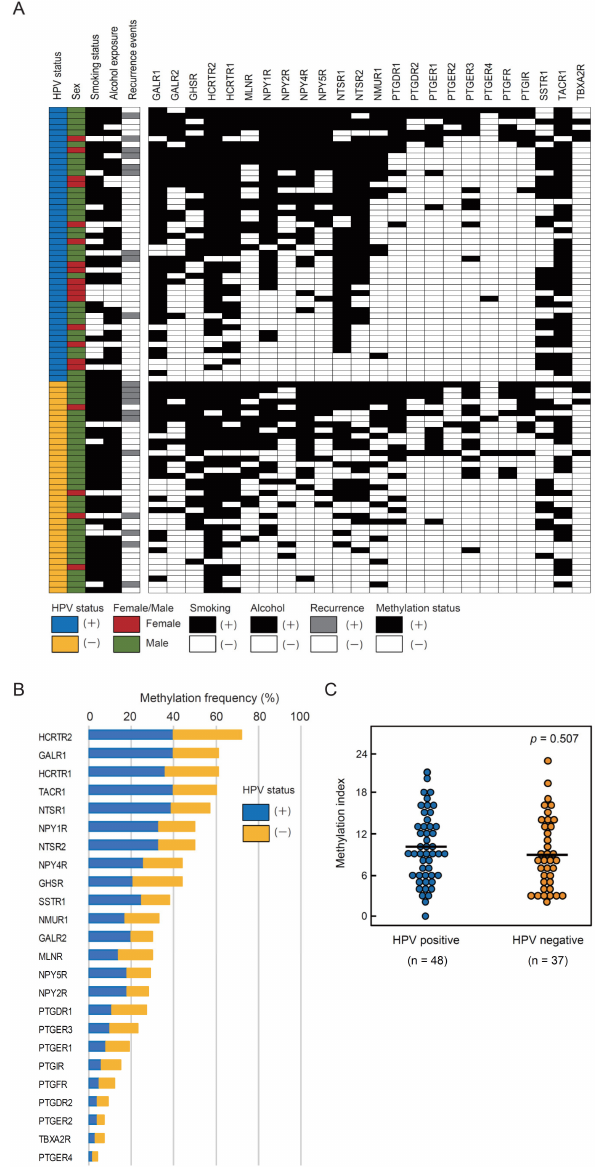
Figure 1. Methylation frequencies for 24 G protein-coupled receptor ( GPCR) genes in oropharyngeal cancer (OPC) tissue samples. ( A ) Comparison of methylation statuses of the promoters of 24 GPCR genes in patients with human papillomavirus (HPV)-associated and HPV-negative OPC. ( B ) Bar graph showing methylation frequencies (%) of 24 GPCR genes in the verification cohort. Blue bars, samples of HPV-associated cases; orange bars, samples of HPV-negative cases. ( C ) The mean methylation index values for HPV-associated and HPV-negative groups have been compared using the Student’s